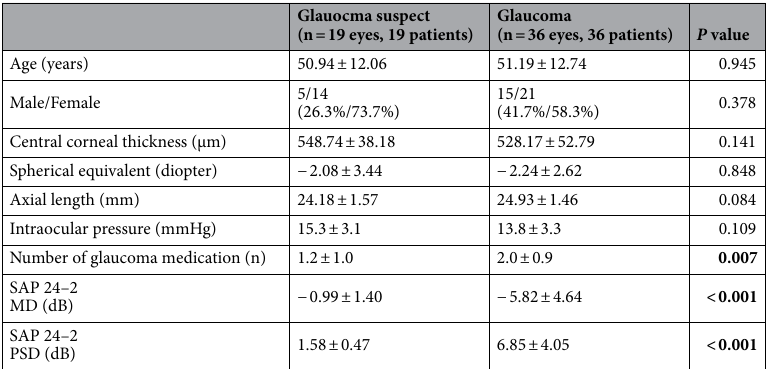
Table 1. Demographics of patients with glaucoma or suspected glaucoma. MD, mean deviation; PSD, pattern standard deviation; SAP, standard automated perimetry. *Statistically significant differences between two groups ( P < 0.05) by student’s t-test for continuous variables or chi-squared test for categorical data are indicated in